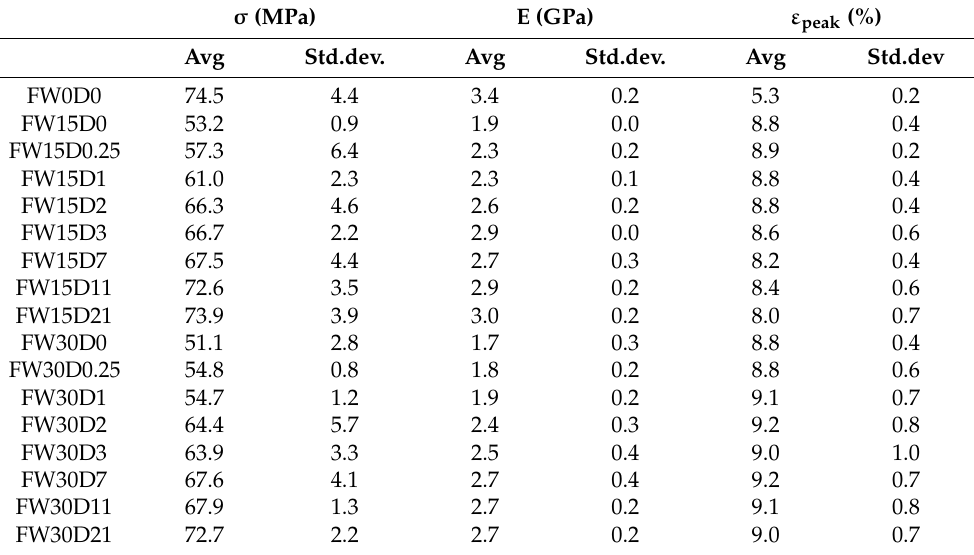
Table 1. Main flexural properties at varying wet–dry times for flax